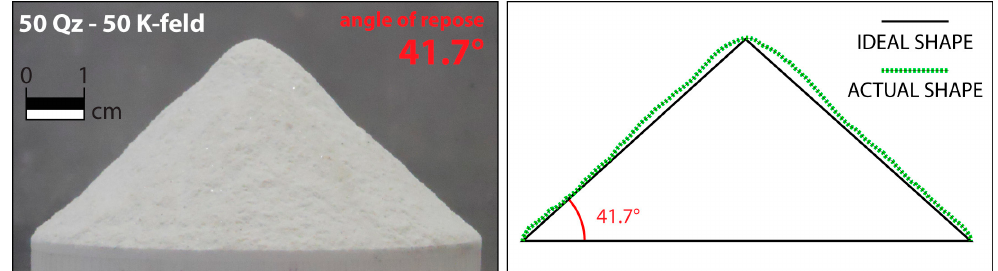
Figure 5. Example of an ideal heap shape compared to the actual heap shape (here for the 50 Quartz— 50 K-feldspar mixture). The strong deviation from the ideal shape indicates a high cohesion.